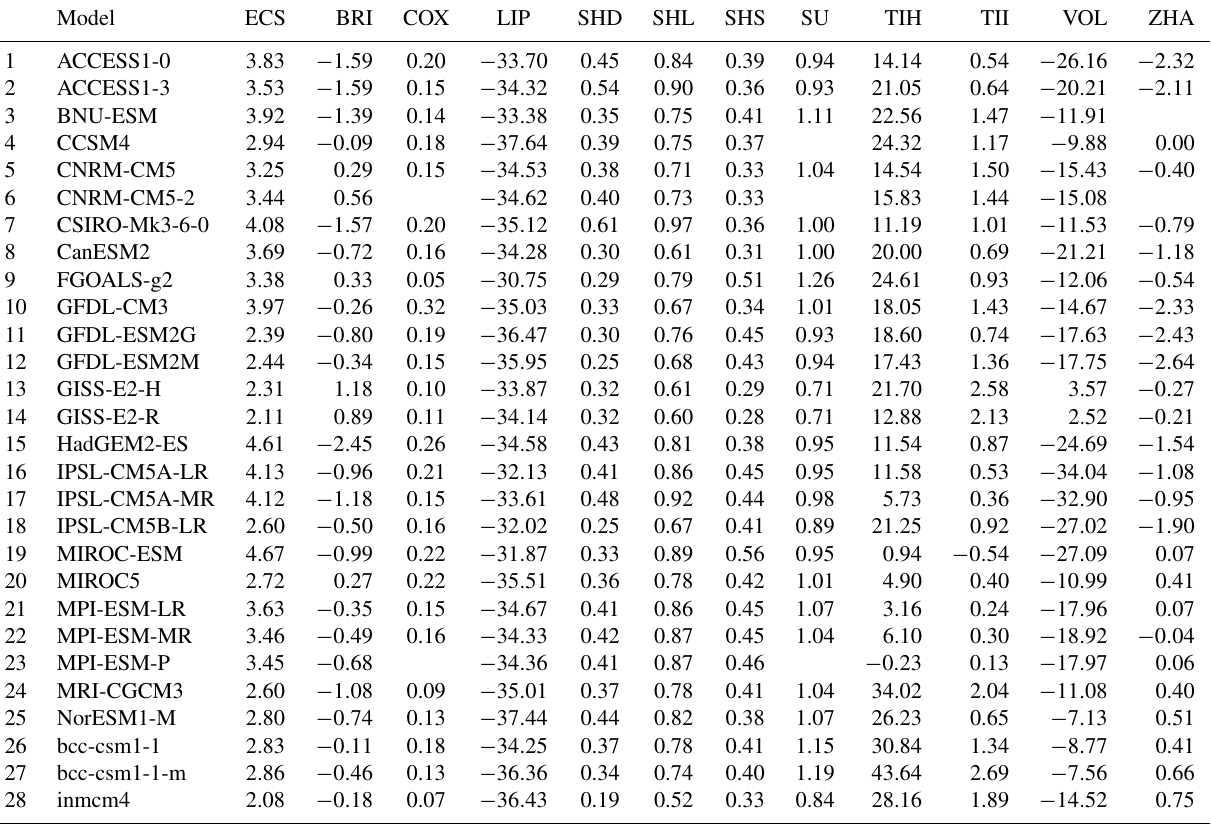
Table A1. All participating CMIP5 models including their ECS values (in K) and x axis values for the different emergent constraints. Details on all constraints (including the units) are given in Table 1. The leftmost column corresponds to the index used in all